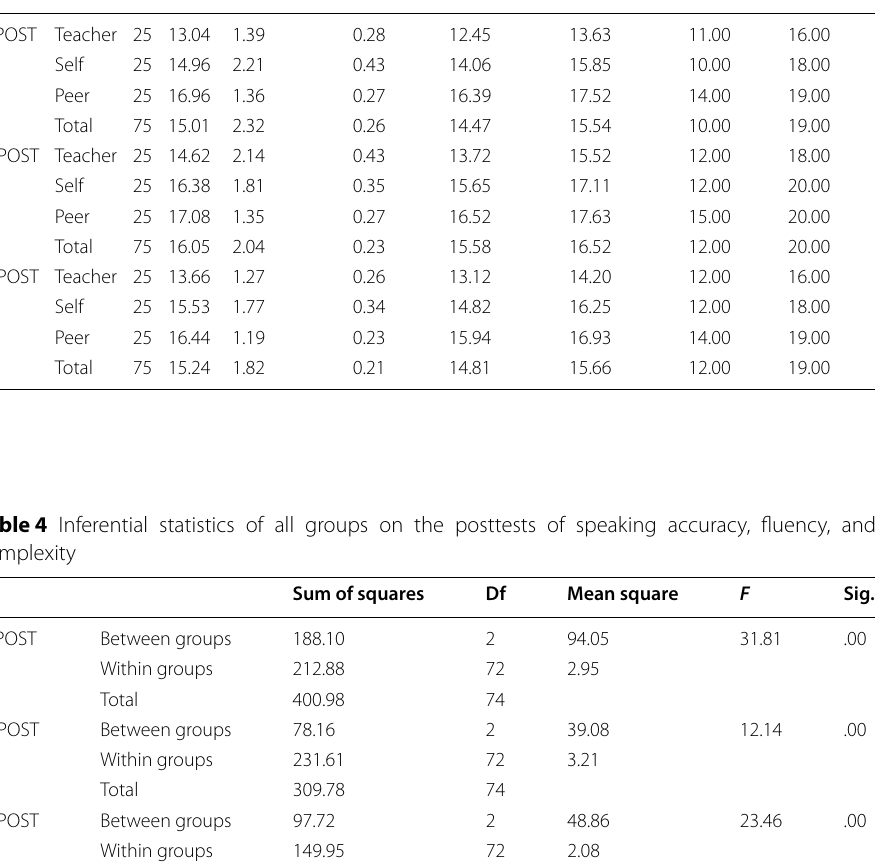
Table 3 Descriptive statistics of all groups on the posttests of speaking accuracy, fluency, and complexity N Mean Std. Std. error 95% confidence interval deviation for mean